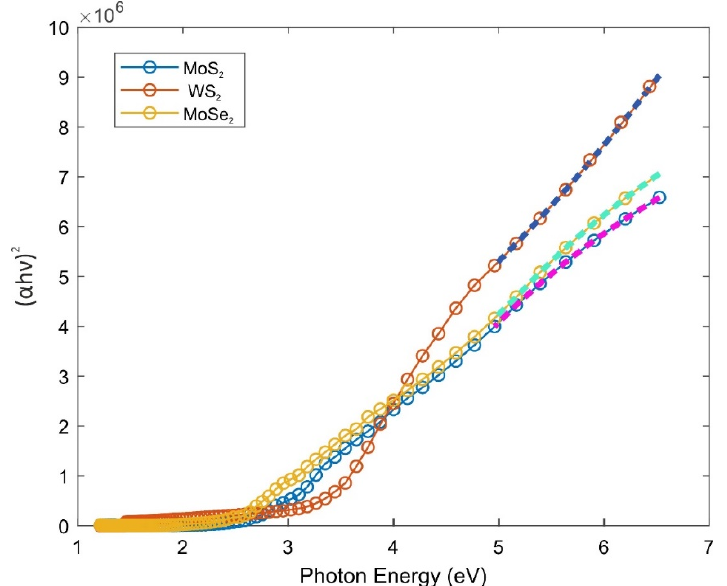
Figure 6. Tauc plots of MoS 2 , WS 2 , MoSe 2 enhanced PAAm composite gels. The linear fitting equations given in Table 2 were used to calculate band gap energies of these composite gels. Table 2. The calculated band gap energies of all composites from the Tauc plots. Type of the Composite